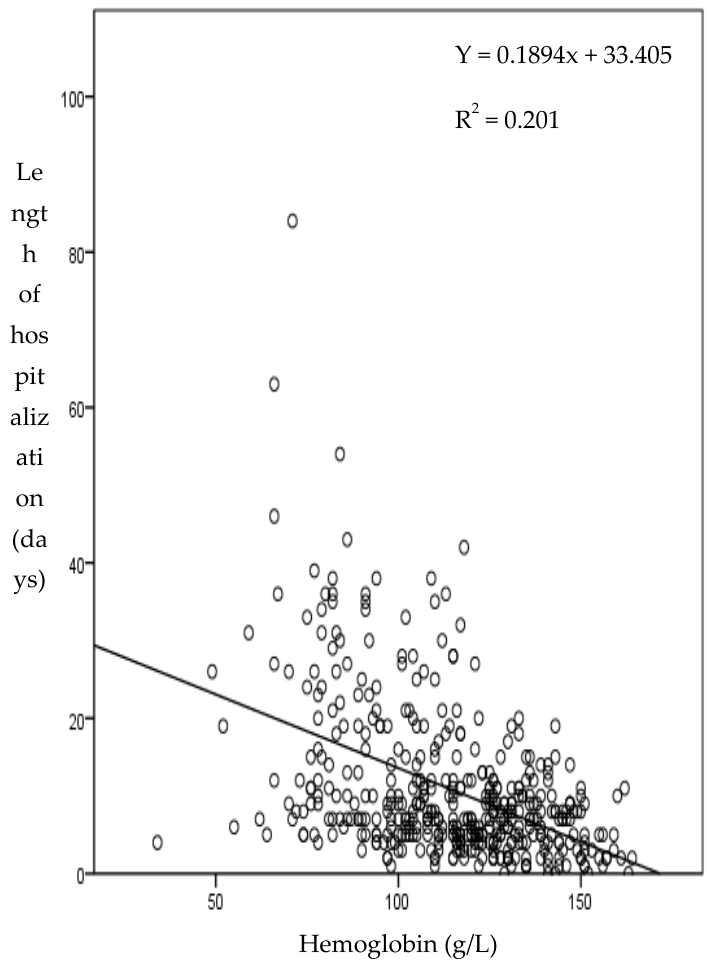
Figure 1. Relation between length of hospitalization and hemoglobin level.